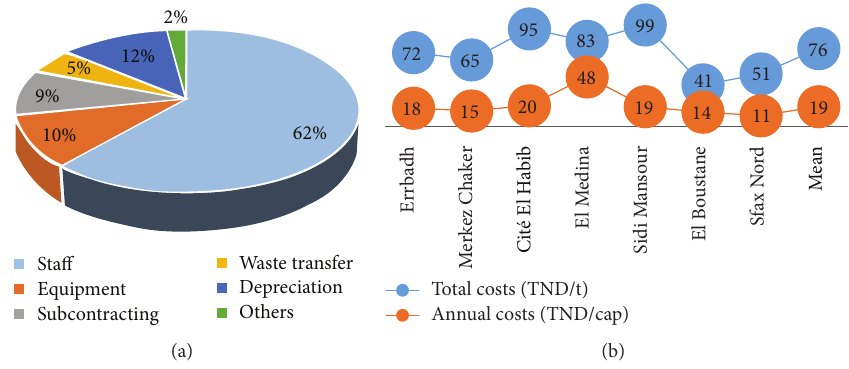
Figure 3: Fees and costs of SW collection/transport in the municipality of Sfax [6].